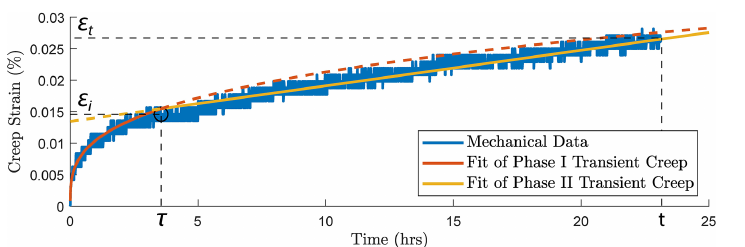
Figure A5. Illustration of the method used to pick up the transition (circle) from phase I to phase II transient creep deformation. Two-phase model for the time evolution of creep strain. The transition (circle) from phase I to phase II creep deformation is selected based on the intersection of the power-law fit function of phase I creep (red) and linear fit function of the phase II creep (yellow).